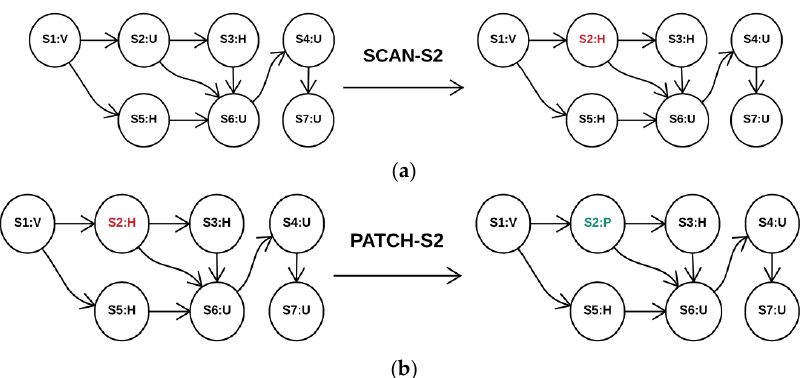
Figure 12. ( a ) Each node represents a function and status (V: VULNERABLE, H: HACKED, U: Figure 12. Each node represents a function and its status (V: Vulnerable, H: Hacked, U: Unknown, UNKNOWN, P: PATCHED); ( b ) system admin chooses action PATCH-S2. P: Patched). ( a ) system admin chooses action scan-S2; ( b ) system admin chooses action patch-S2. S1-Smart Meter Collector, S2-Smart Meter sync head, S3-Billing Engine, S4-Outage Management System, S5-Vendor Specific Head, S6-Meter Data Management, S7-Electricity Control Center.